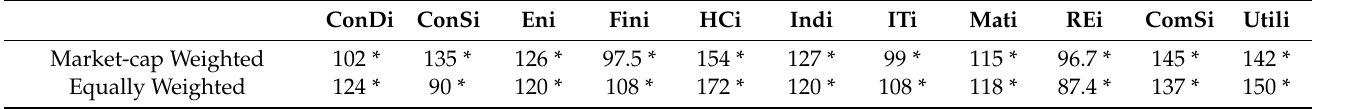
Table 3. Bee, Ben Salem and Carrasco (BBC) unit root